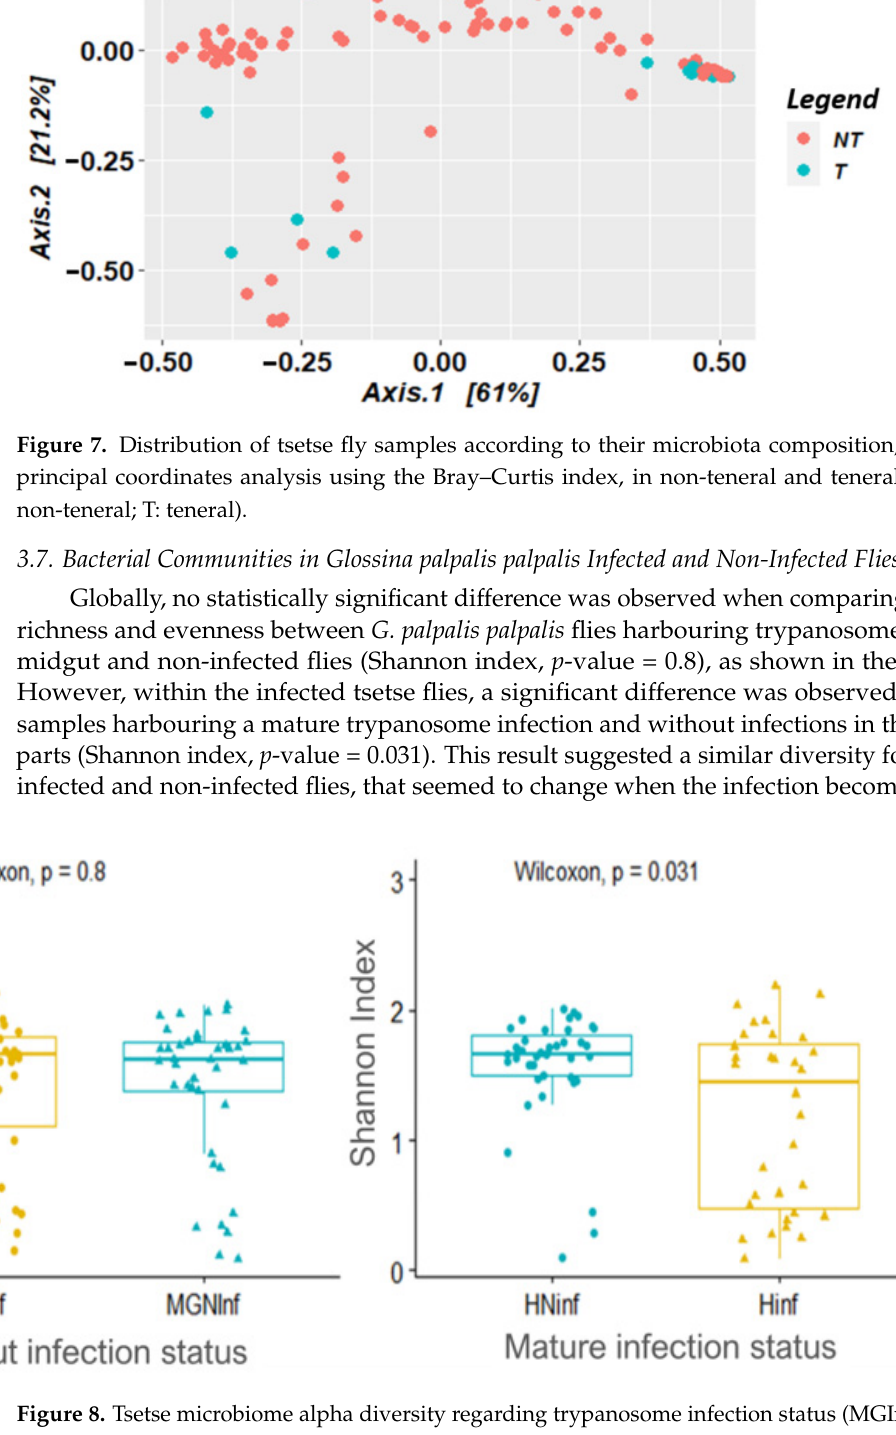
( B ) Figure 9. Distribution of tsetse fly samples according to their microbiome composition, based on principal coordinates analysis using the Bray–Curtis index, within trypanosome infection status: ( A ) midgut infection, ( B ) mature infection (MGInf: midgut infected; MGNInf: midgut non-infected; Hinf: head infected or mature infection; HNinf: head non-infected). Furthermore, the hierarchical clustering using the Bray–Curtis dissimilarity index clearly showed a similarity in microbial communities of flies according to infection status (midgut infection and mature infection), despite the high variability observed in the different groups and no clear “higher-level” clustering of infected flies on one hand, and uninfected ones on the other hand (Figure 10). Figure 10. Hierarchical cluster dendrogram, based on Bray–Curtis Index values, showing the relationship between different tsetse microbiome communities and infection status. ( A ) midgut infection with trypanosomes, ( B ) mature infection with trypanosomes.